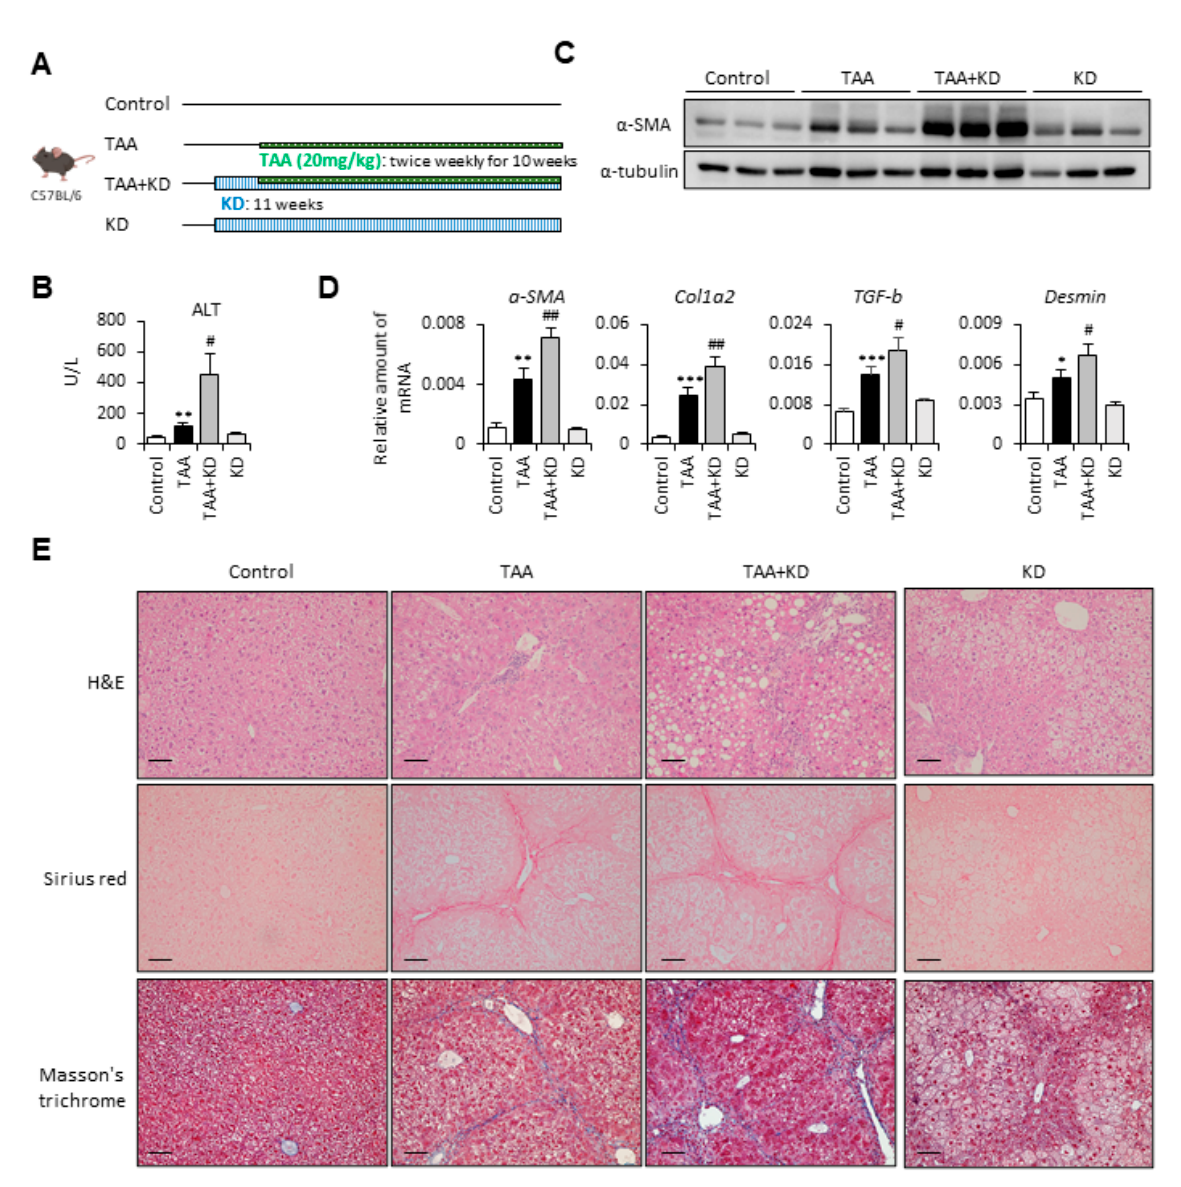
Figure 2. Ketogenic diet enhanced the severity of thioacetamide (TAA)-induced liver fibrosis. ( A ) Study design of the in vivo experiment. ( B ) Serum samples were collected at the end of the experiment, and the serum ALT was assessed. ( C ) Representative results from Western blot analyses of α -SMA expression and ( D ) qPCR analyses of α -SMA, Col1a2, TGF- β , and Desmin gene expression. ( E ) Representative H&E, Sirius red, and Masson’s trichrome staining images of liver tissues. Scale bars: 0.1 mm. *, p < 0.05; **, p < 0.01; ***, p < 0.001 vs. white bar. #, p < 0.05; ##, p < 0.01 vs. black bar. N = 5 in each group. Data are shown as means ± SEM.